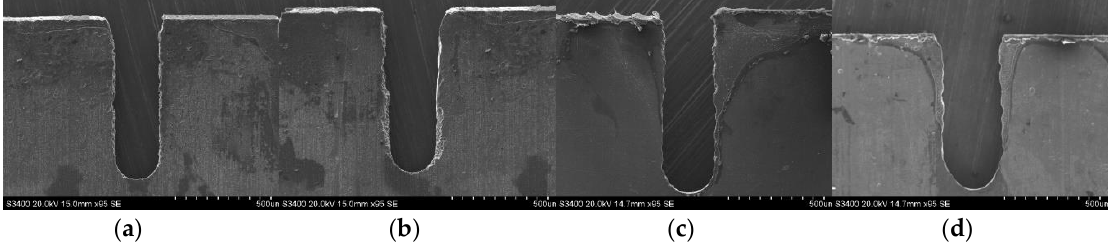
Figure 7. The slits on aluminum layers machined by different applied voltages: ( a ) 7.0 V; ( b ) 7.5 V; ( c ) 8.0 V; ( d ) 8.5 V.